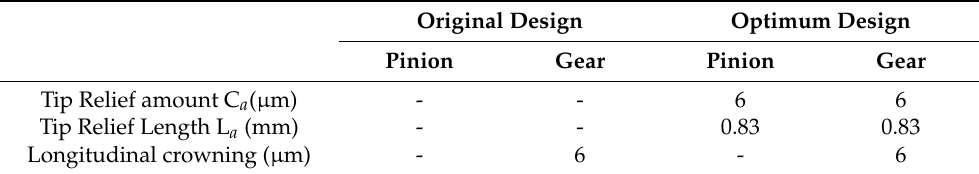
Table 4. Optimum tip relief modification